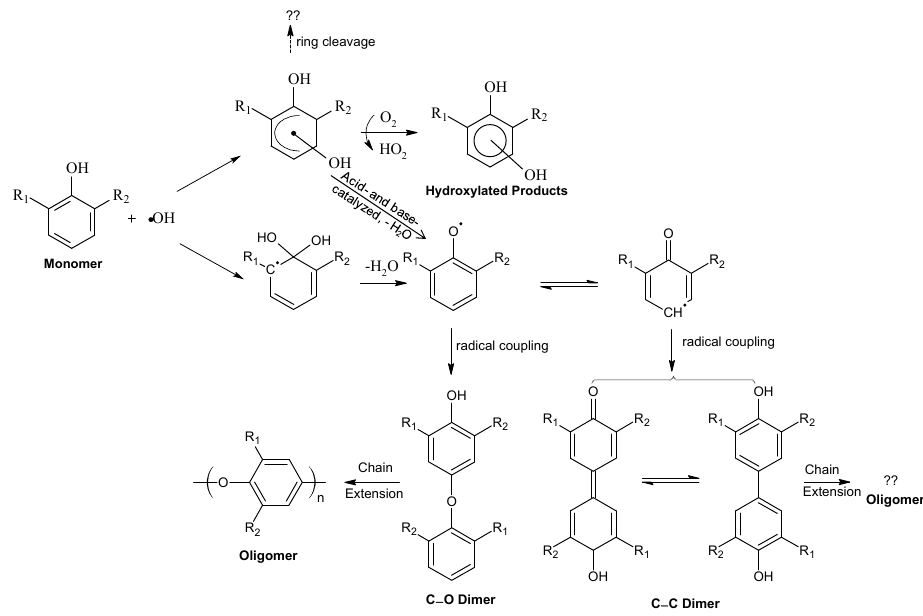
Fig. 5. Proposed mechanisms for formation of hydroxylated species (e.g., Olariu et al., 2002) and dimer and higher oligomers (e.g., Kobayashi and Higashimura, 2003) from phenolic precursors. Phenol: R 1 = H , R 2 = H ; Guaiacol: R 1 = OCH 3 , R 2 = H ; Syringol: R 1 = OCH 3 , R 2 = OCH 3 . Note that while radical coupling here (and in Fig. 7) is shown through the carbon opposite (para) the phenoxyl group, other geometric isomers will also be formed during these